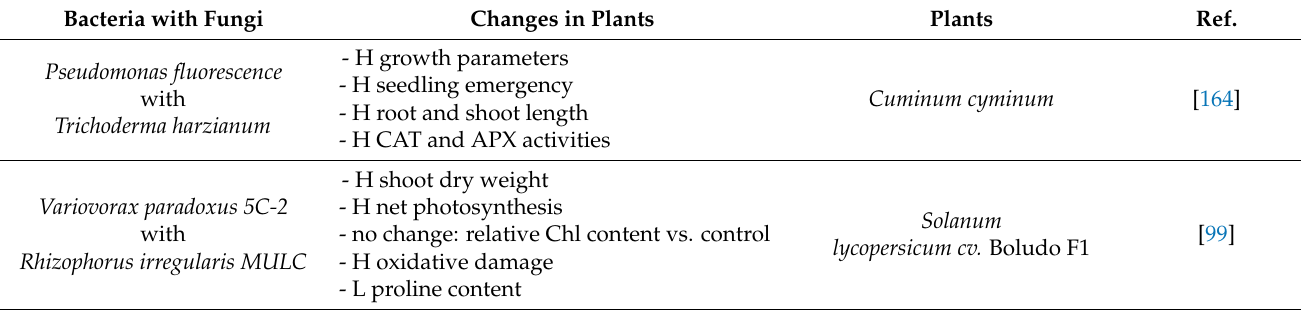
Table 3. Selected activities of beneficial consortia (bacteria with fungi) under drought stress conditions in horticultural plant species; H—higher level/content; L—lower level/content; CAT—catalase; APX—ascorbate peroxidase; Chl—chlorophyll. Bacteria with Fungi Changes in Plants Plants